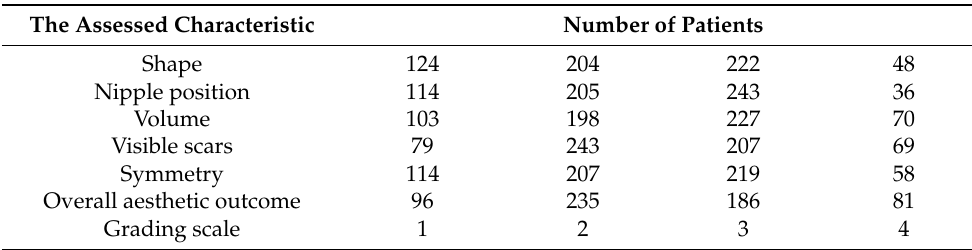
Table A8. The assessment of the outcomes of the operation completed by the doctors 6 months after surgery of the patients allocated in the control